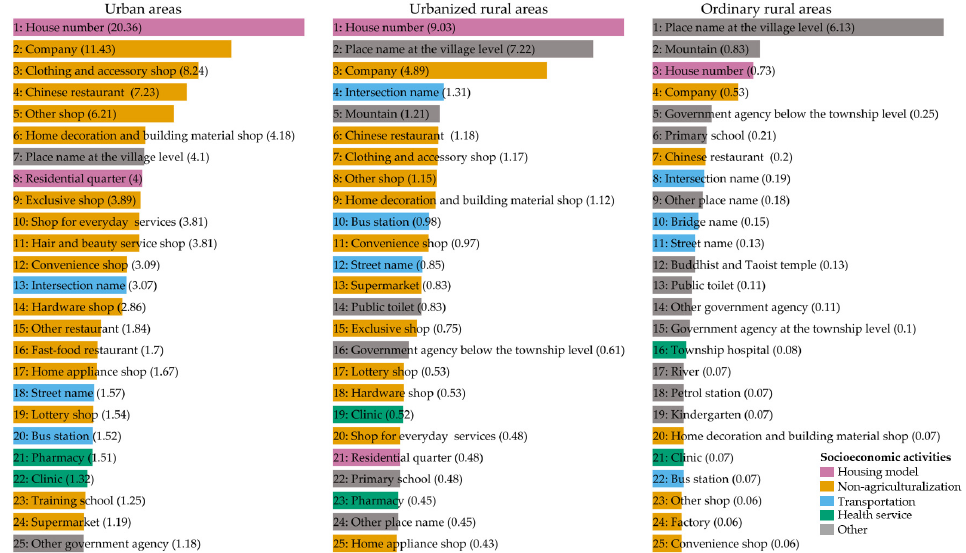
Figure 5. Average frequencies of the top 25 POI categories in the urbanized rural areas, ordinary rural areas, and urban areas in 2015. The top 25 POI categories were divided into: housing model, non ‐ agriculturalization, transportation, health services, and other. The numbers in parentheses represent the average frequencies of the POI categories. For example, the average frequency of house number POIs in the urban areas was 20.36, which indicates that each village ‐ level adminis ‐ trative unit in the urban areas had 20.36 house number POIs. Descriptions of the top 25 POI cate ‐ gories are given in Table